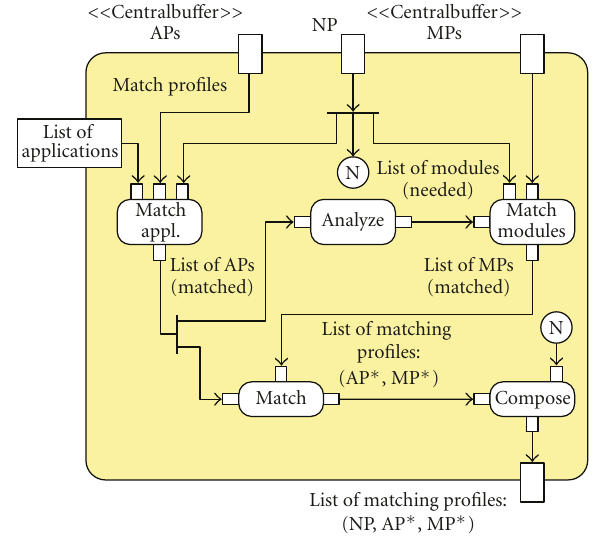
Figure 6: Activity diagram of the profile matching